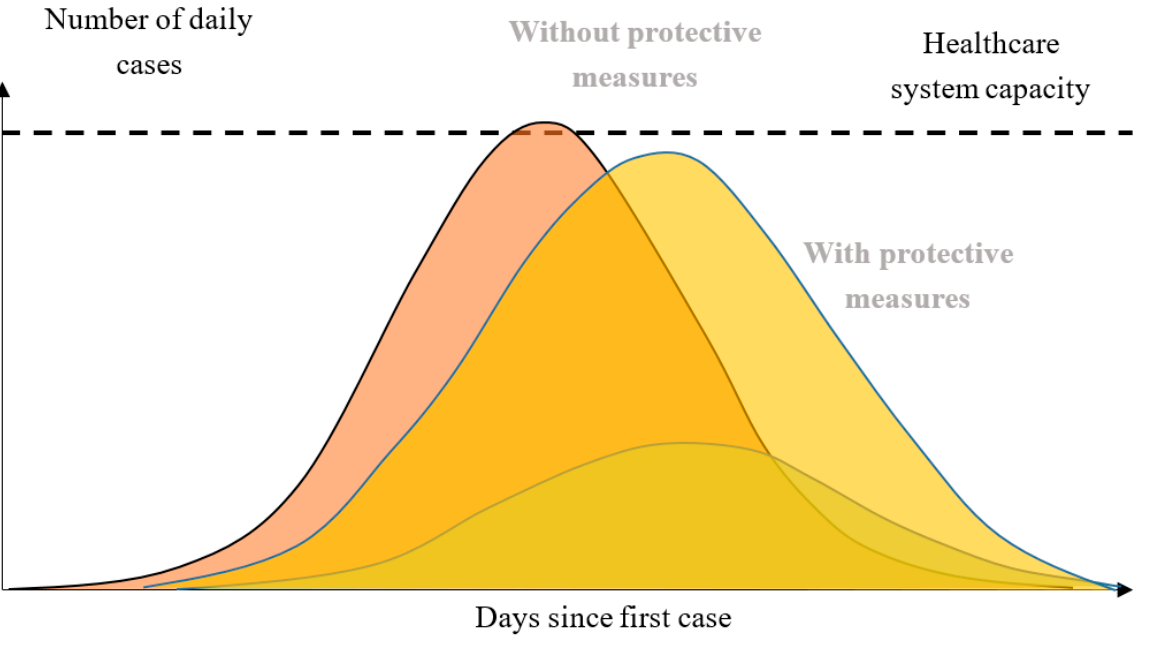
Figure 4. The number of patients and the capabilities of the healthcare system after increasing of its capacity.